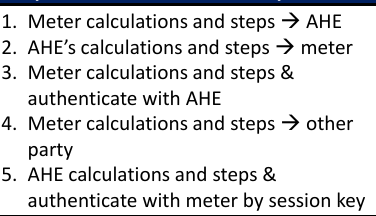
Figure 7. Algorithm of